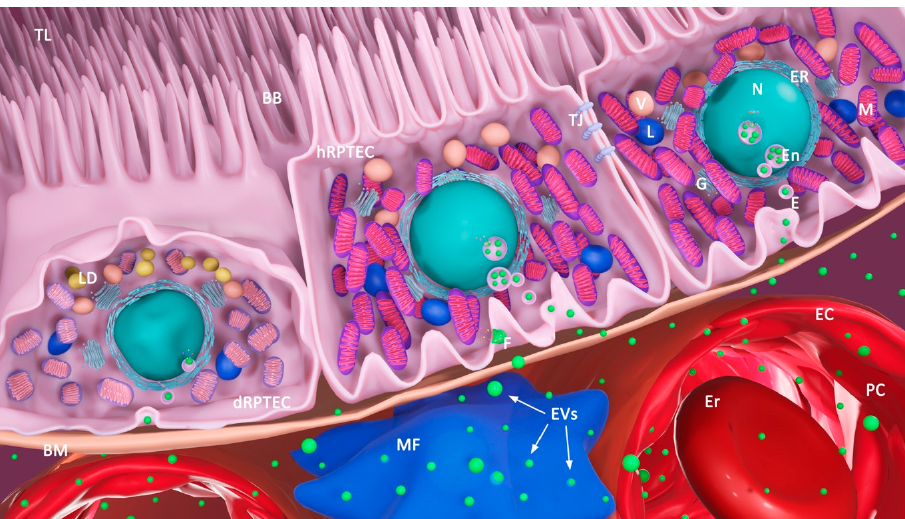
Figure 3. Renal proximal tubular epithelial cell as a target of therapeutic EVs. Therapeutic EVs can deliver their cargo (proteins, RNA, and other biomolecules) to the RPTEC either by fusion (F) with its plasma membrane and release of the cargo into the RPTEC´s cytoplasm or endocytotic uptake (E) of EVs by the RPTEC. BB, brush border; TL, tubular lumen; BM, basal membrane; En, endosome; TJ, tight junction; dRPTEC, diseased RPTEC; hRPTEC, healthy RPTEC; M, mitochondria; LD, lipid droplet; V, vacuole; L, lysosome; G, Golgi apparatus; ER, endoplasmic reticulum; N, nucleus; EV, extracellular vesicle; E, endocytosis; F, fusion of EVs with plasma membrane of RPTEC; MF macro- phage; PC, peritubular capillary; EC, endothelial cell; Er, erythrocyte; EVs released from RPTEC are not shown.